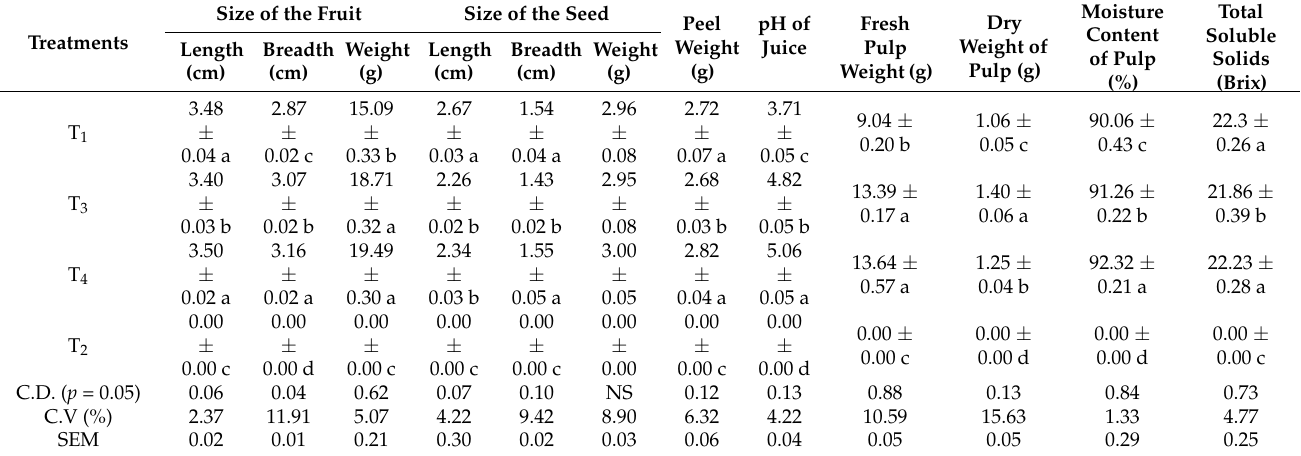
Table 4. Impact of insect-pollination on the quantitative parameters (Mean ± SE) of L.